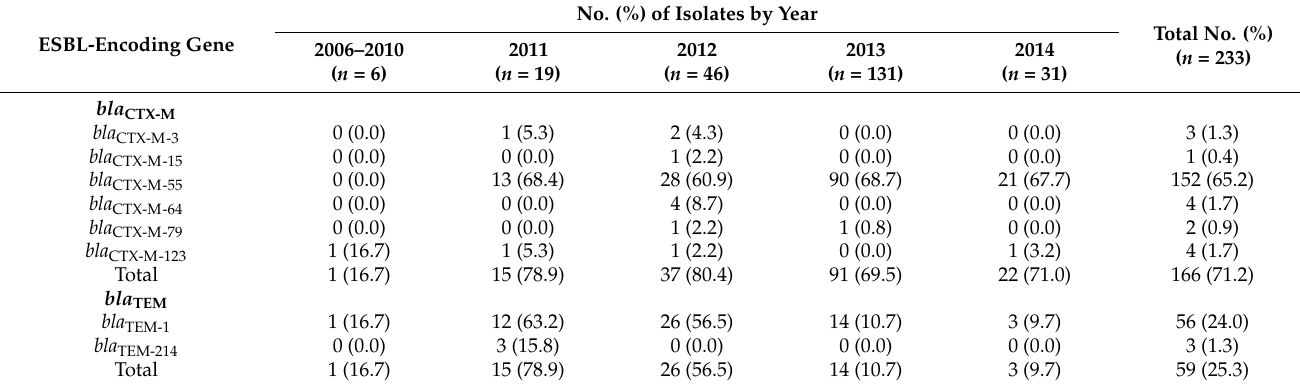
Table 2. The prevalence of ESBL-encoding genes of ESBL-producing S. Enteritidis isolates recovered from different years.